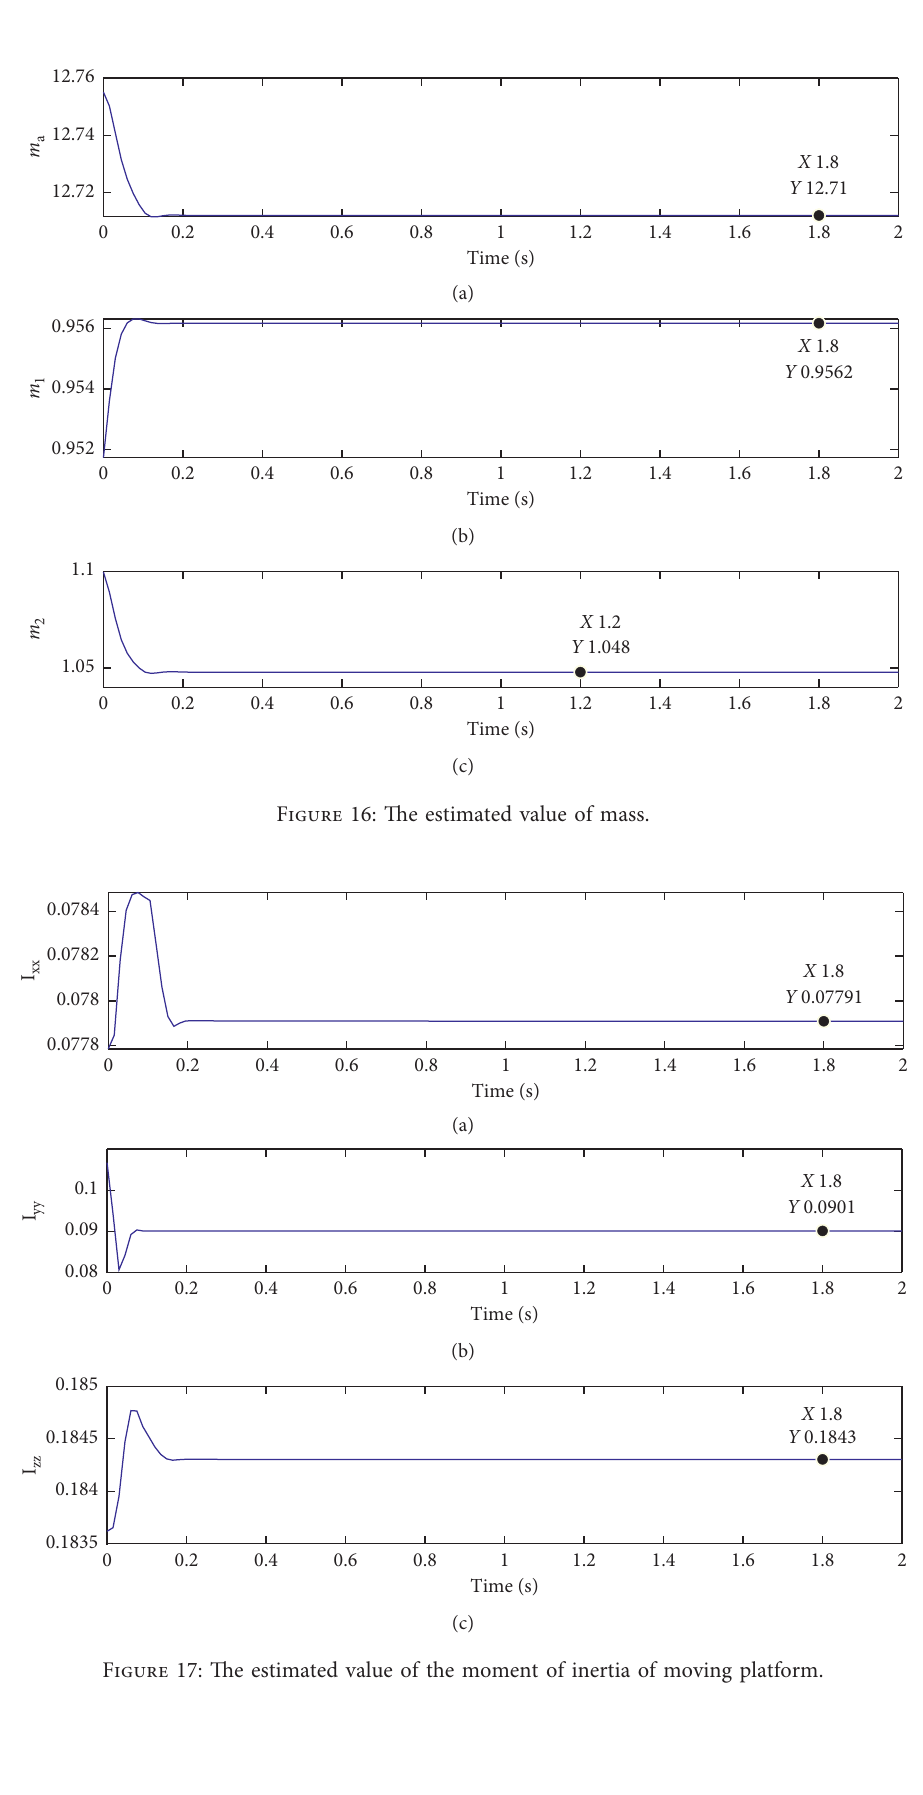
Figure 17: The estimated value of the moment of inertia of moving